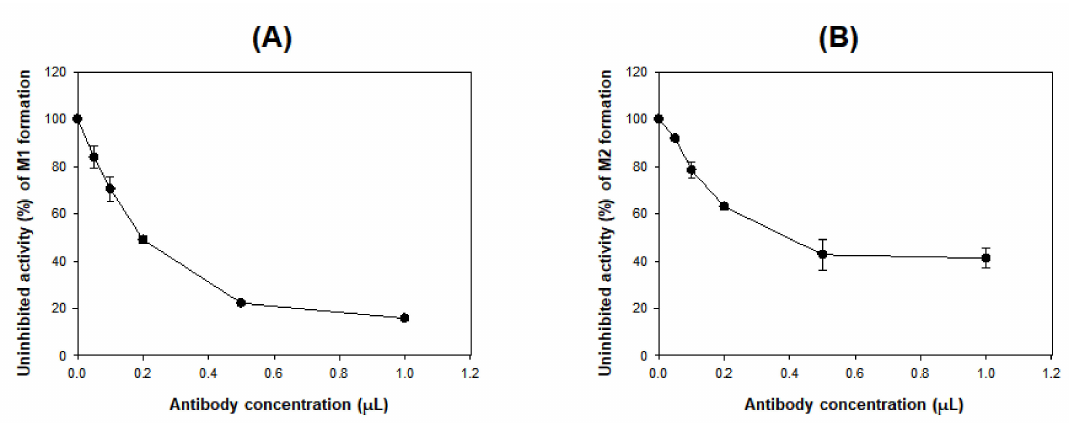
Figure 6. E ff ects of anti-CYP3A4 antibody on the formation of ( A ) M1 and ( B ) M2 from DWP16001 (5 µ M) to in pooled human liver microsomes. Each data point represents the mean ± S.D. ( n = 3).